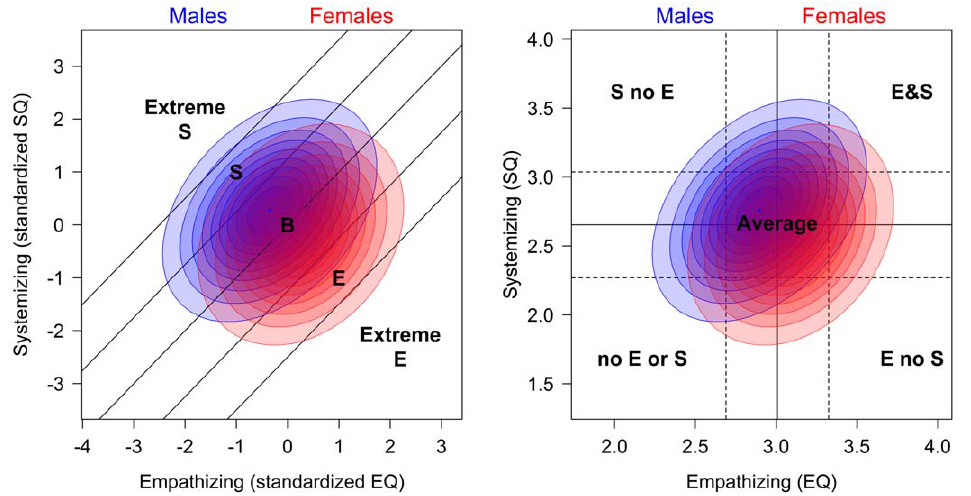
Figure 8. Gender differences (assuming bivariate normality) for the classification schemes shown in Figures 1 and 2. Each band in these figures represents 10% of males and females. The outer ellipse includes 90% of the population for males (in blue) and females (in red).